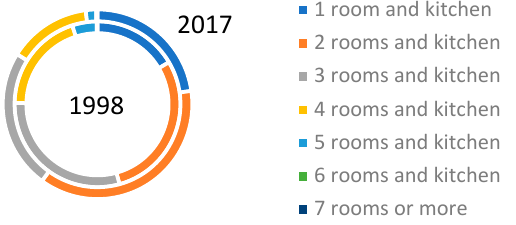
Figure 3. Apartments in new construction by type in Stockholm region in 1998 and 2017.